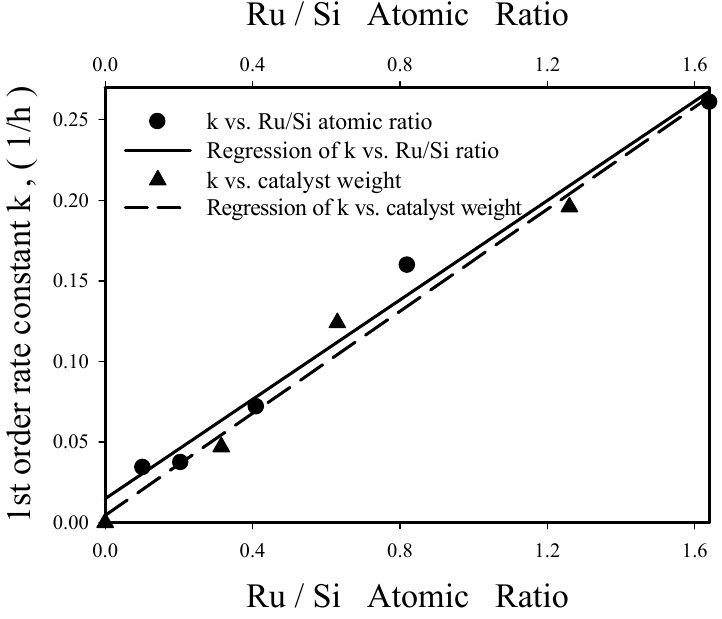
Figure 12. Pseudo-first-order rate constant k (at 130 °C and 800 psi) versus Cu/Si atomic ratio and Re-08RuSi catalyst weight.